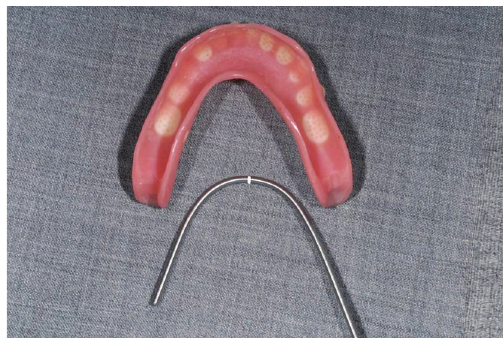
Figure 10: Titanium bar fixed to the denture with acrylic resin.